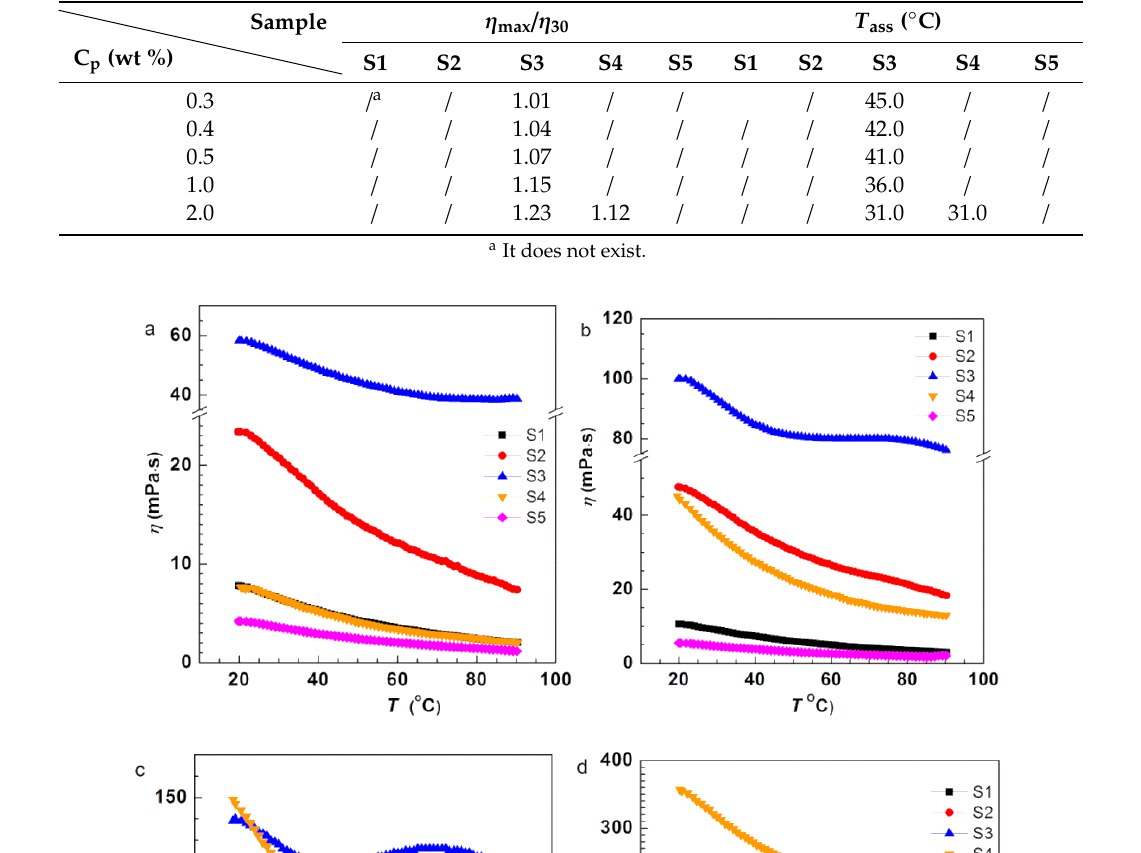
Table 4. Thermoviscosifying ability of di ff erent polymers at five di ff erent concentrations.